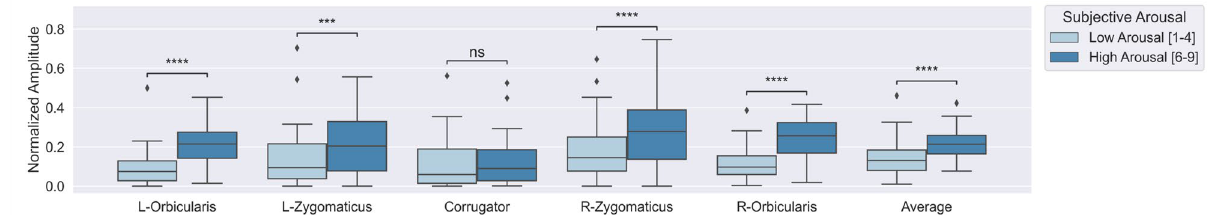
Figure 6. Wilcoxon signed-rank (paired) test with Bonferroni correction for videos with low arousal ratings [1–4] versus videos with high arousal ratings [6–9], applied for each sensor (left orbicularis, left zygomaticus, corrugator, right zygomaticus, and right orbicularis) and their average amplitude. Statistical significance annotations: * if p ∈ [.05, 10 −2 ); ** if p ∈ [10 −2 , 10 −3 ); *** if p ∈ [10 −3 , 10 −4 ); and **** if p ≥ 10 −4 .